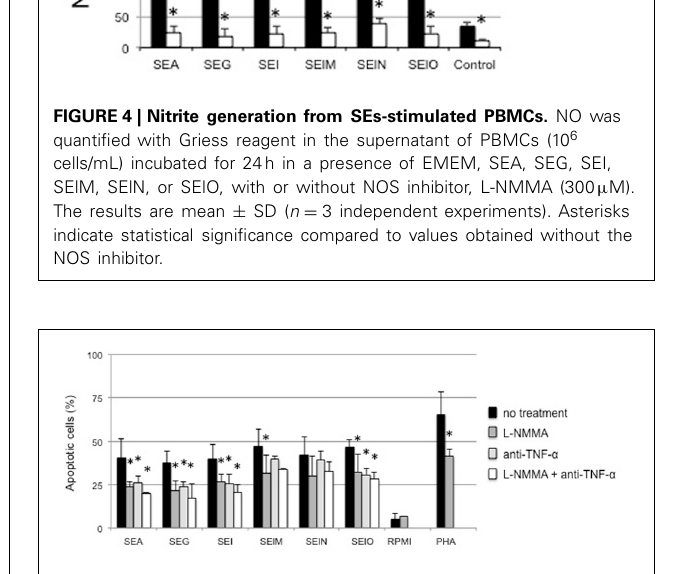
FIGURE 5 | Anti- TNF- α and NO inhibitor, alone and in combination inhibit Hep-2 tumor cells cytotoxicity induced by 10% supernatants from SEA and egcSE-stimulated PBMCs. Hep-2 tumor cells cytotoxicity induced by 10% supernatants from SEA and egcSE-stimulated PBMCs before (black) or after treatment with L-NMMA (dark gray) or anti-TNF- α antibody (light gray) or a combination of L-NMMA plus anti-TNF- α antibody was analyzed by flow cytomerter using FITC-conjugated annexin-V and propidium iodide (IP) staining. The results are expressed as the mean ± SEM ( n = 3 independent experiments). Asterisks indicate statistical significance compared to values obtained before treatment with L-NMMA or anti-TNF- α